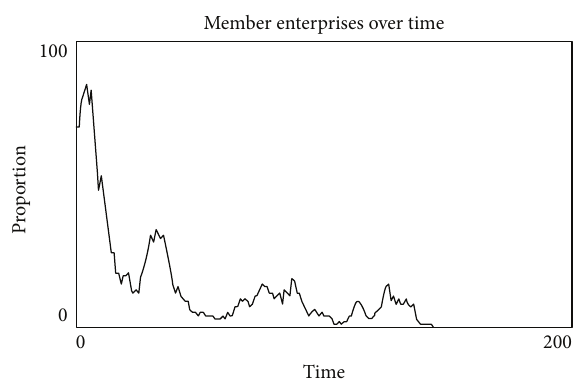
Figure 2: Simulation result for 𝑥 0 = 0.7 and 𝑦 0 = 0.4 .